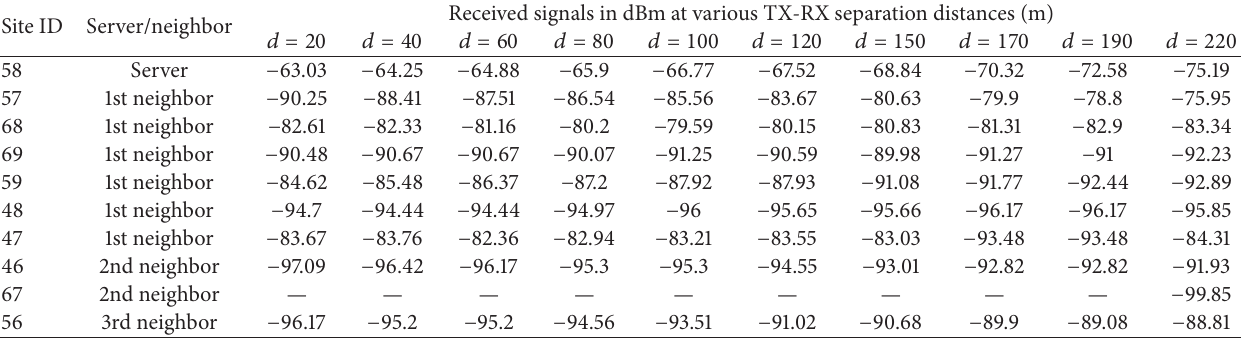
Table 1: Carrier and interference measurements for the 28GHz mm-wave networks using 65 ∘ beamwidth TX antennas for the trisector BS’s. Site ID Server/neighbor